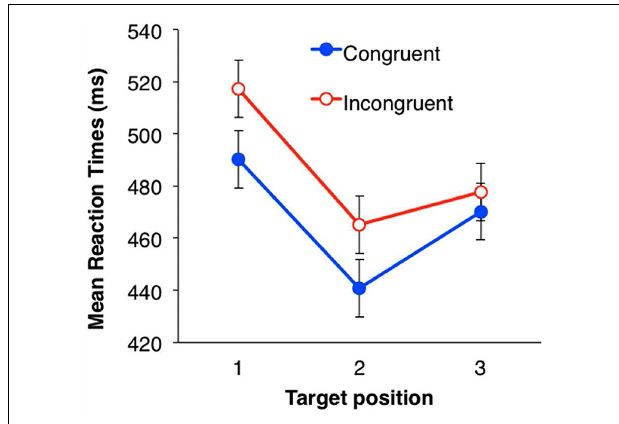
FIGURE 3 | Mean RTs of target detection in Experiment 1. Filled circles (blue) indicate the mean RTs in the congruent eye condition; open circles (red) indicate the mean RTs in the incongruent condition. Error bars represent SE.